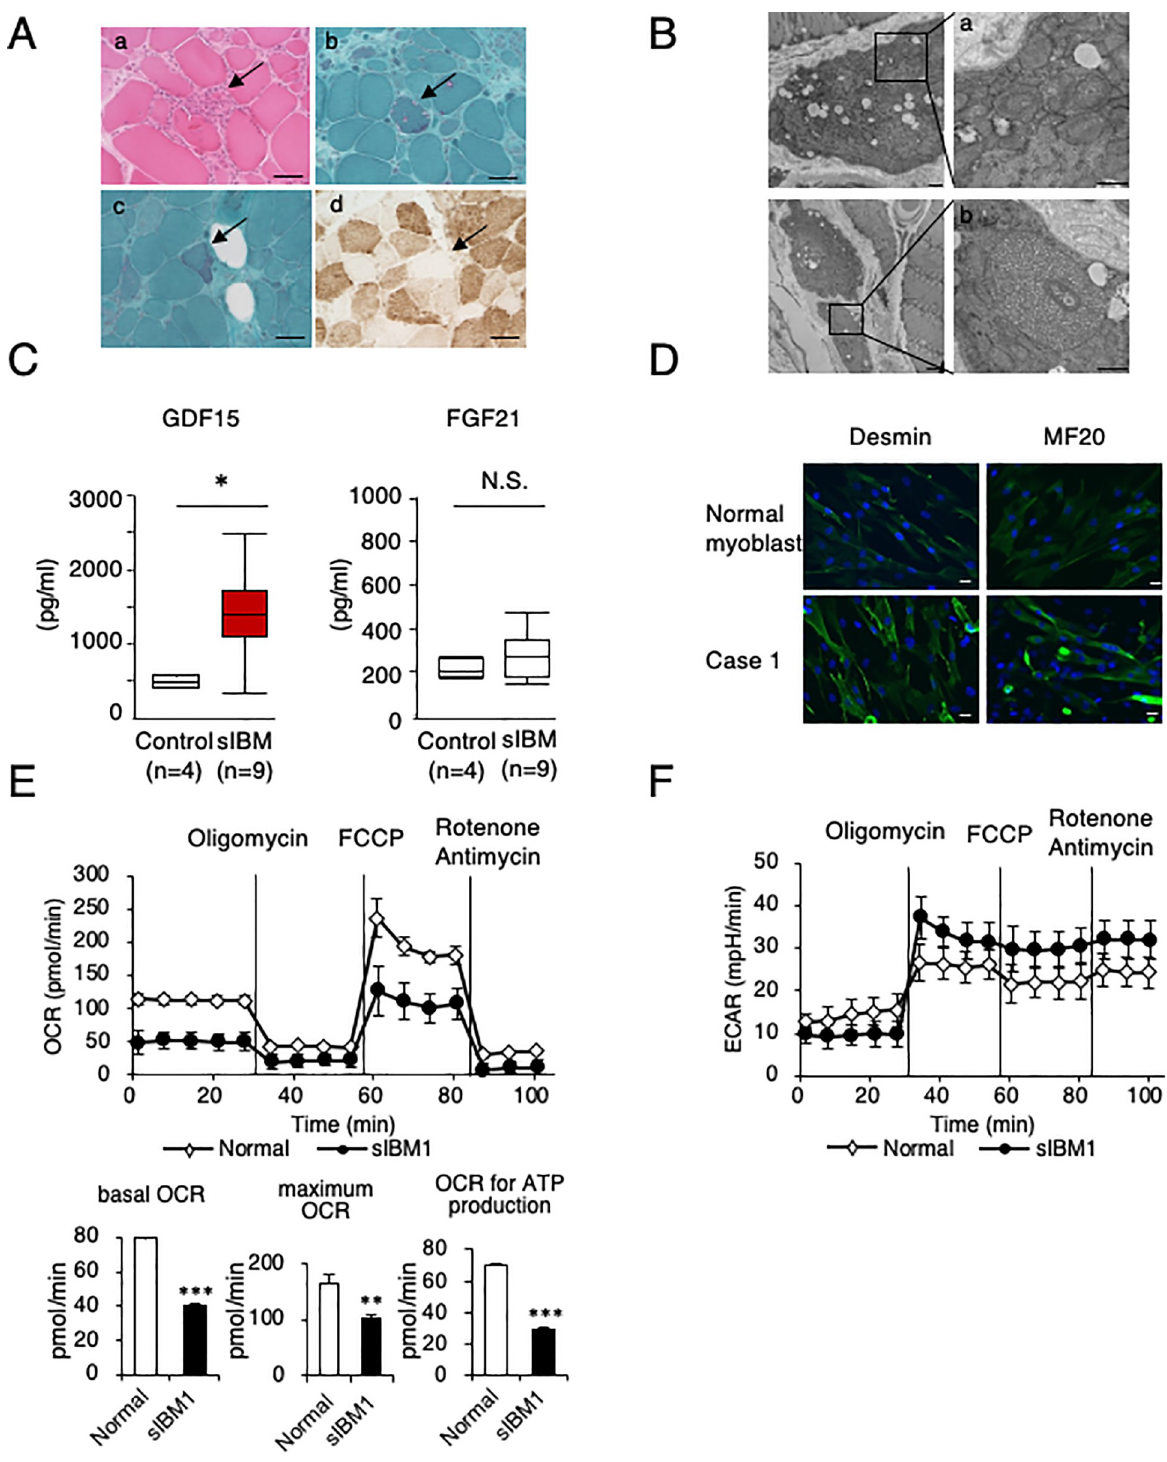
Fig 1. Mitochondrial dysfunction in sIBM patients. A. Pathological images of the muscle tissue from sIBM patient (patient 4). (a) Hematoxylin- eosin staining of muscle biopsy tissue from a patient with sIBM revealed endomysial inflammatory infiltrates invading nonnecrotic fibers (arrow). (b) Modified Gomori trichrome staining of muscle biopsy tissue from a patient with sIBM revealed rimmed vacuoles (arrow). ( c ) Modified Gomori trichrome staining of muscle biopsy tissue from a patient with sIBM revealed ragged-red fibers (arrow). (d) The absence of cytochrome c oxidase staining in muscle biopsy tissue from a patient with sIBM (arrow). B. Pathological image of muscle tissue from an sIBM patient (patient